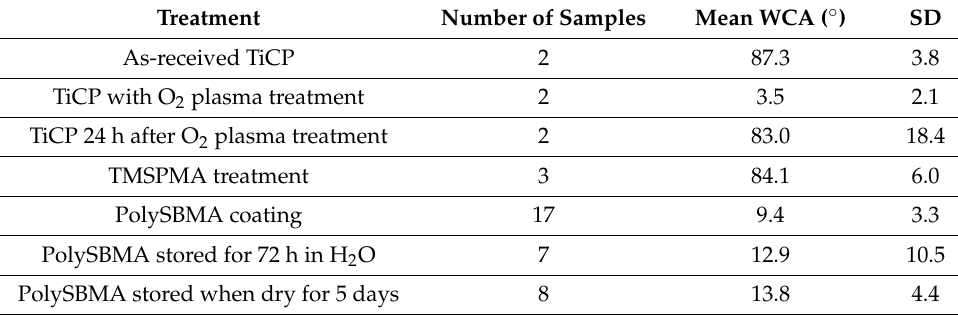
Figure 4. Comparative water contact angle (WCA) measurements of the different surfaces: TiCP: as-received TiCP; O 2 plasma: TiCP after oxygen plasma treatment; 1 d O 2 Plasma: TiCP aged for 24 h after plasma treatment; TMSPMA: TiCP with O 2 plasma treatment followed by a CVD treatment with TMSPMA; pSBMA: TMSPMA-primed surface followed by photografting with polySBMA; pSBMA for 3 d in H 2 O: polySBMA-coated surface soaked in deionized water for 72 h; pSBMA for 5 d in air: pSBMA with dry aging for 5 days. Statistical analysis was performed on the polySBMA coated surface using ANOVA testing. Table 4. WCA measurements and their standard deviations (SD).